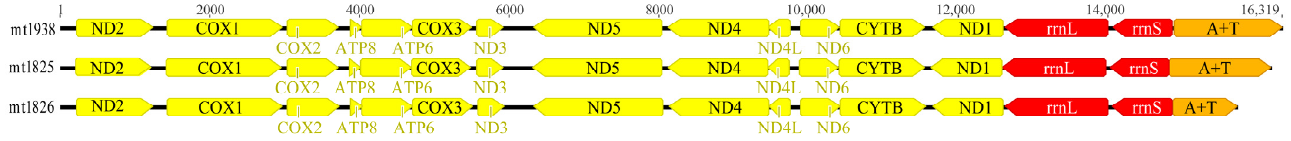
Figure 1. Linearised representation of gene arrangements in the three newly sequenced mitogenomes. mt1825: Longzhouacris mirabilis ; mt1826: Ranacris albicornis ; mt1938: Conophyma zhaosuensis .